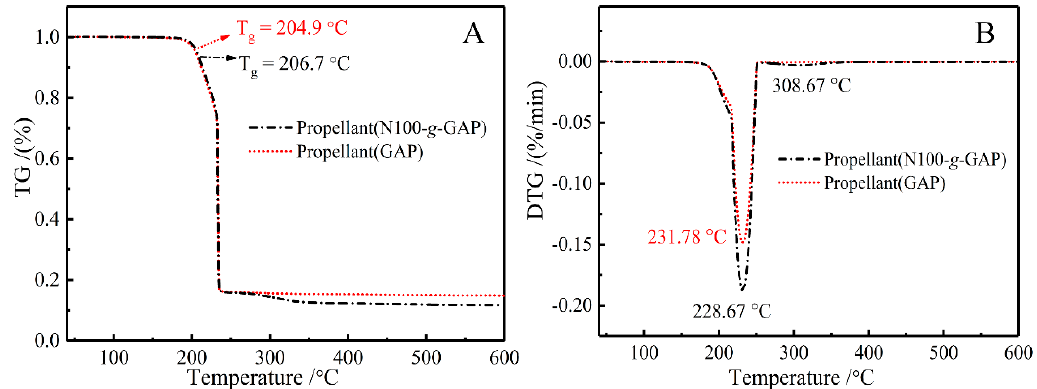
Figure 6. Thermal stability analysis of propellants prepared by N100- g -GAP and GAP ( Mn = 4000 g/mol). ( A ) TG curves, ( B ) DTG curves.